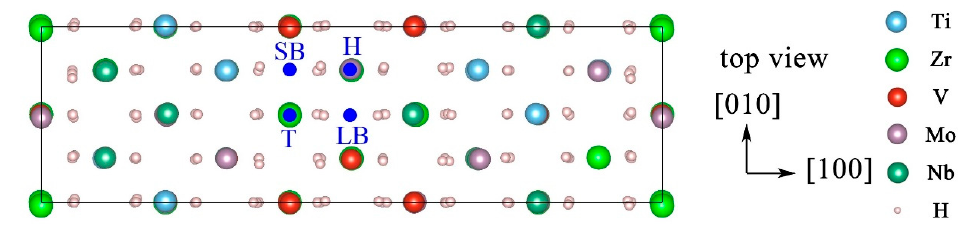
Figure 7. Top view of the TiZrVMoNb hydride (110) surface. The top (T), long bridge (LB), hollow (H) and short bridge (SB) sites are indicated.